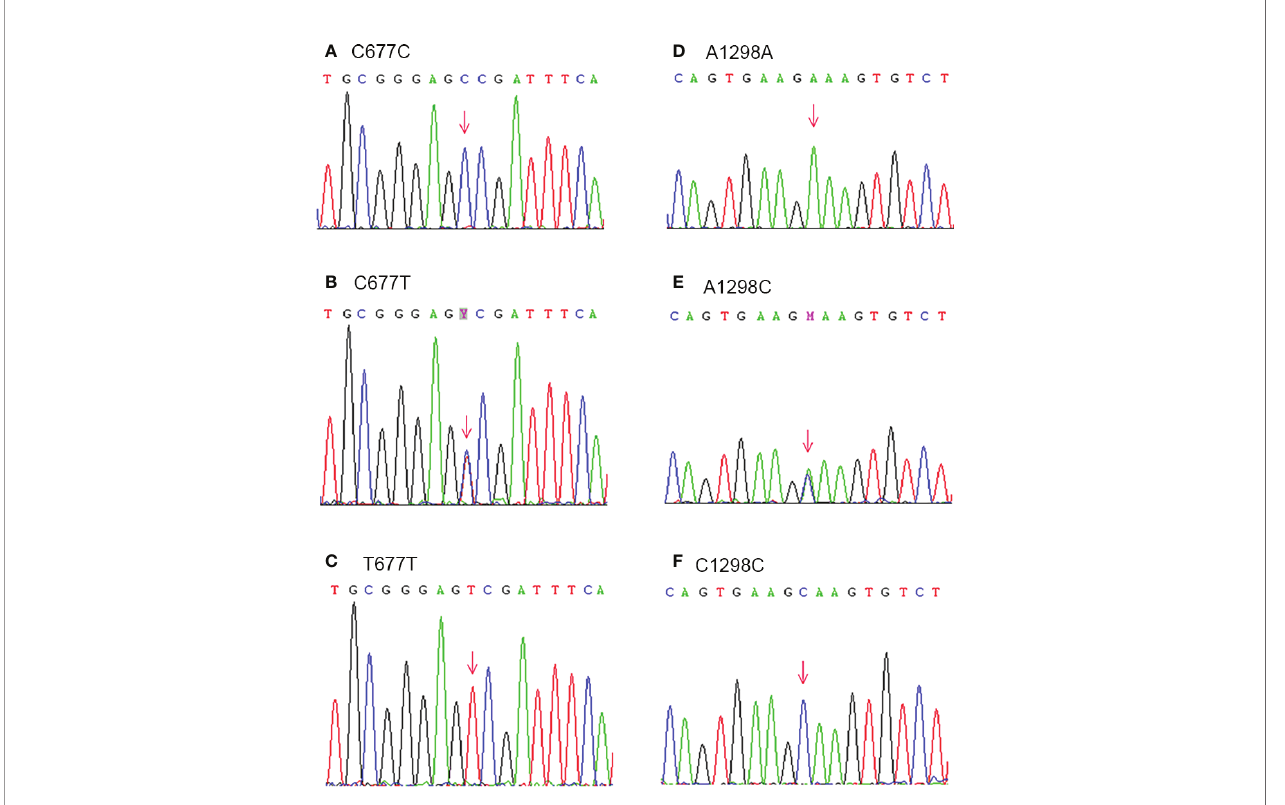
FIGURE 2 | Genetic variations of MTHFR C677T (Ala 222 Val) (A – C) and A1298C (Glu 429 Ala) (D – F) were detected by PCR following Sanger